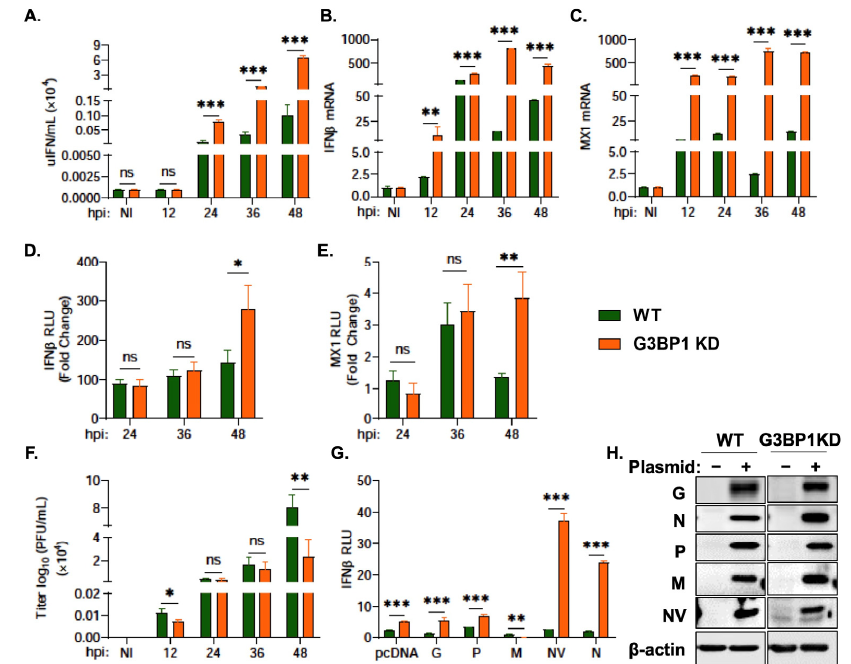
Figure 6. G3BP1 regulates IFN signaling during VHSV Ia infection. WT and G3BP1 KD cells were infected with VHSV Ia for indicated times at MOI = 1 and ( A ) media was collected at the indicated times post infection and used to quantitate IFN produced in IFN bioassays as described in methods, and mRNA levels of ( B ) IFN β , ( C ) MX1 was measured by qRT-PCR and normalized to spiked internal control and presented as fold change in expression compared to no treatment. WT and G3BP1 KD cells were transfected with ( D ) IFN β -luc or ( E ) MX1-luc for 48 h, followed by infection with VHSV Ia for indicated times at MOI = 1. Luciferase values were quantified and normalized to total protein concentration of each sample and non-infected sample. ( F ) WT and G3BP1 KD cells were infected with VHSV Ia for indicated times at MOI=1 and viral titers in supernatants was determined by plaque assay. ( G ) WT and G3BP1KD cell line were co-transfected with IFN luciferase, fish MAVS and myc-VHSV Ia proteins as indicated. pcDNA3.1 plasmid vector was used for transfection balancing and baseline control. Luciferase activity was analyzed at 72 h post transfection and RLU normalized to total protein concentration in each sample, ( H ) immunoblots comparing expression of myc-VHSV Ia proteins as indicated in cell lysates using myc antibodies and β -actin. The data represent Mean ± SD and was performed in triplicate. WT: wildtype; KD: knockdown; NI: not infected; ns, not significant; *, p < 0.01; **, p < 0.001; ***, p < 0.001, ns = “not significant”.